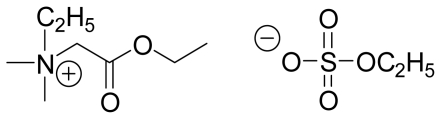
Molecular structure of 2-ethoxy-1-ethyl-1,1-dimethyl-2-oxoethanaminium ethyl sulfate ([QuatGly-OEt][EtOSO3]).